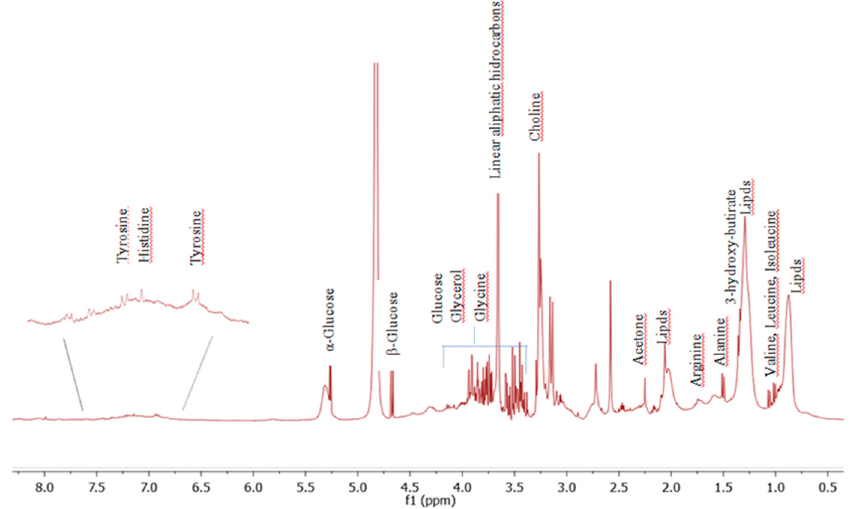
Figure 3. 1D Carr Purcell Meiboom Gill (CPMG) 1H NMR spectrum representative of serum metabolites.